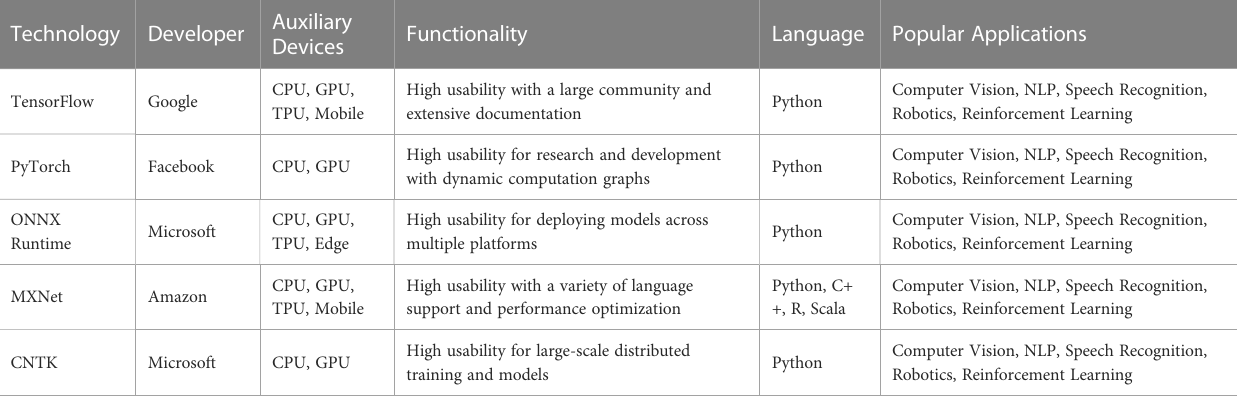
TABLE 2 Comparison of popular arti fi cial intelligence